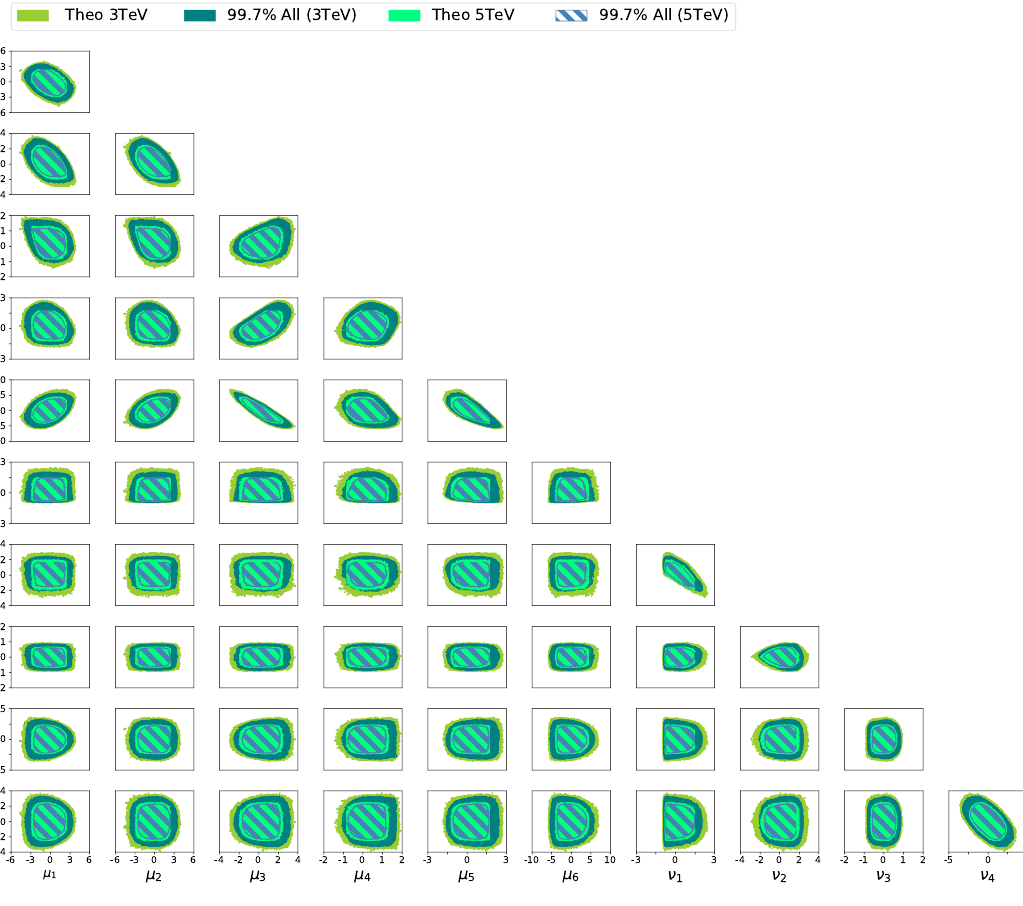
Figure 8 . Two-dimensional correlations among the quartic couplings of the scalar potential. The allowed (99.7% probability) regions from the global fit are compared with the results obtained with only theoretical constraints, imposing perturbative unitarity and RG stability up to 3 and 5 TeV.